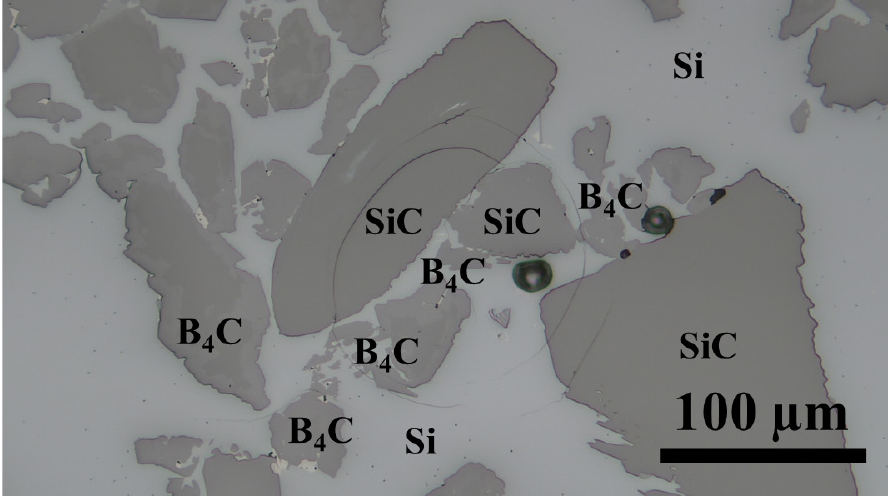
Figure 10. This behavior will eventually affect other mechanical properties of composites, Figure 11. Optical image of a spherical indent on the composite showing more area of contact to such as the composite strength. encompass more of the response of all three phases.